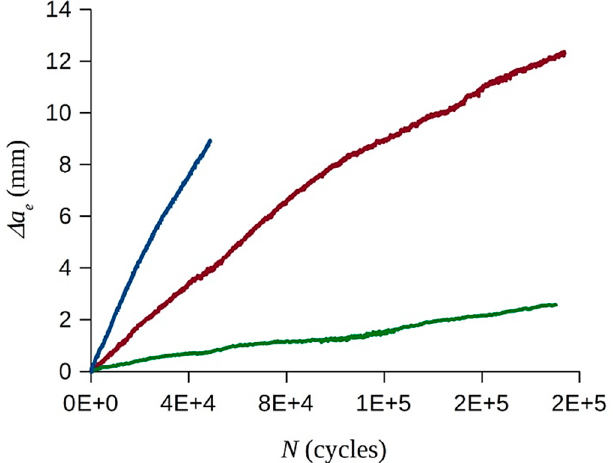
Figure 7. Examples of effective crack growth versus the number of load cycles plots.